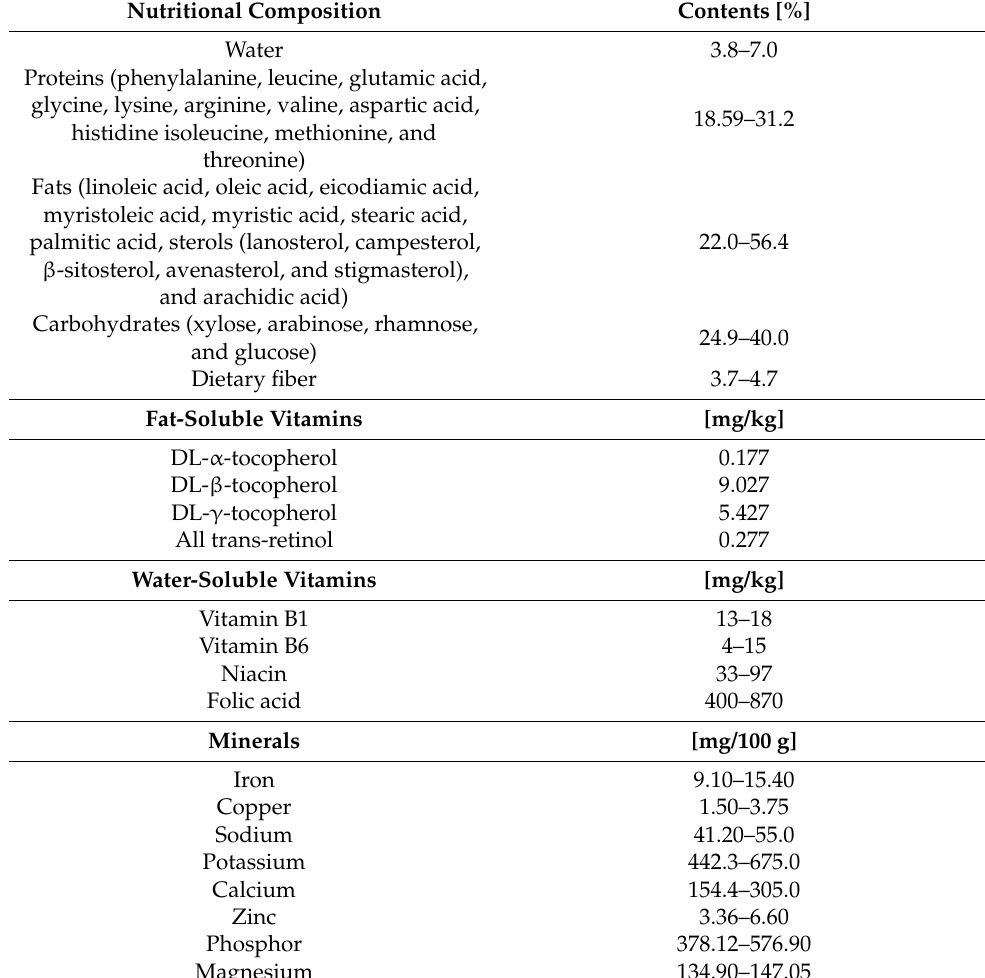
Table 1. Nutritional composition of Nigella sativa seeds.